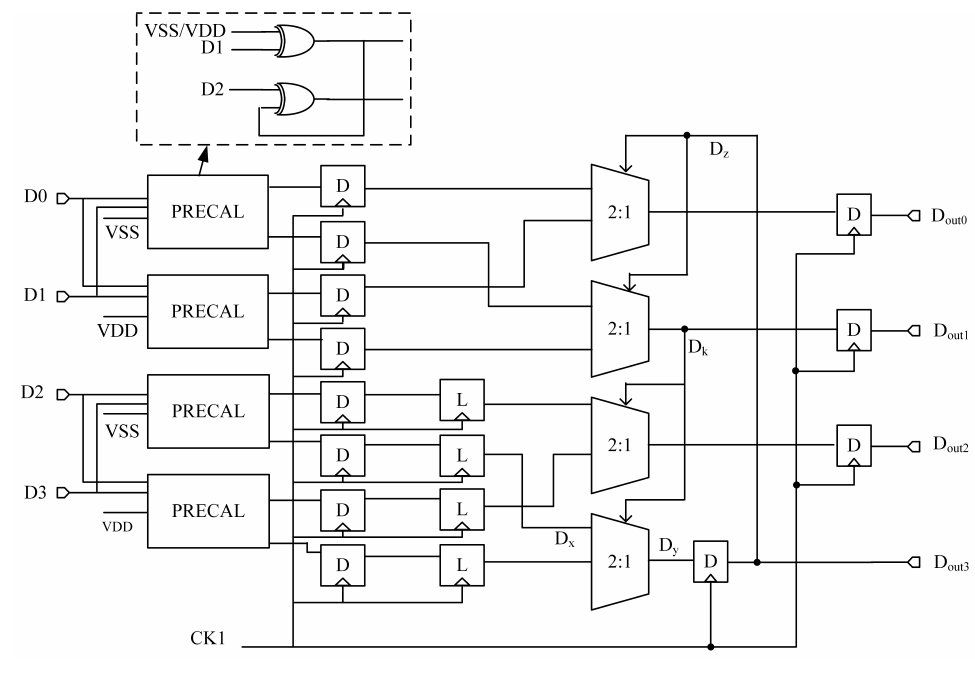
Figure 6. Proposed precoding structure